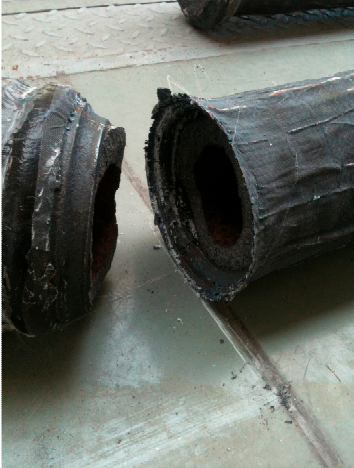
Figure 15. Brittle fracture mechanism in the column strengthened in one stage.